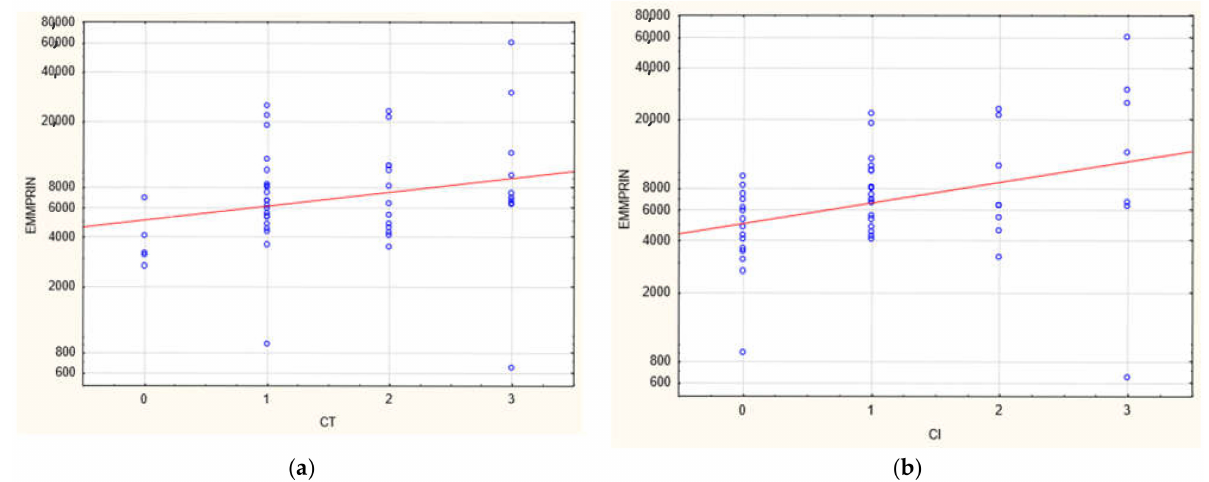
Figure 4. Positive correlation between EMMPRIN/CD147 serum concentration and severity of biopsy specimen lesions such as CI ( b ) and CT ( a ) (R = 0.39 and 0.029, respectively, p < 0.05).